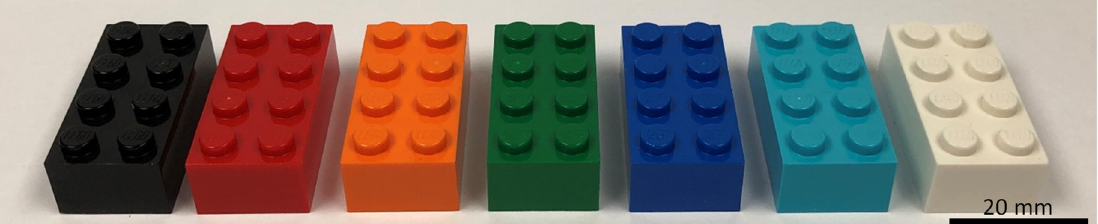
Figure 4. The seven different colored Lego bricks used in the first experiment: black, red, orange, green, blue, turquoise, and white (left to right).